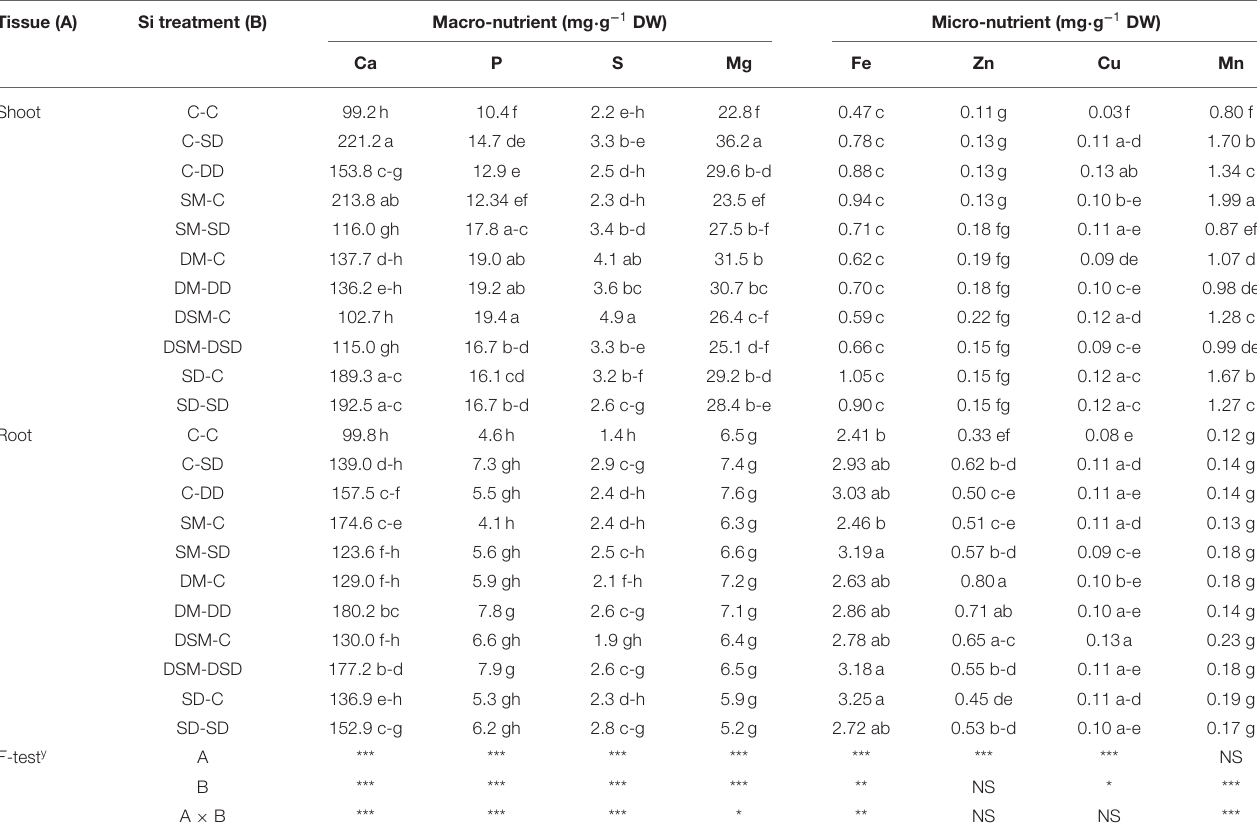
TABLE 5 | Mineral contents in leaves and root of “Kuemsil” transplants as affected by different Si treatments. Tissue (A) Si treatment (B)